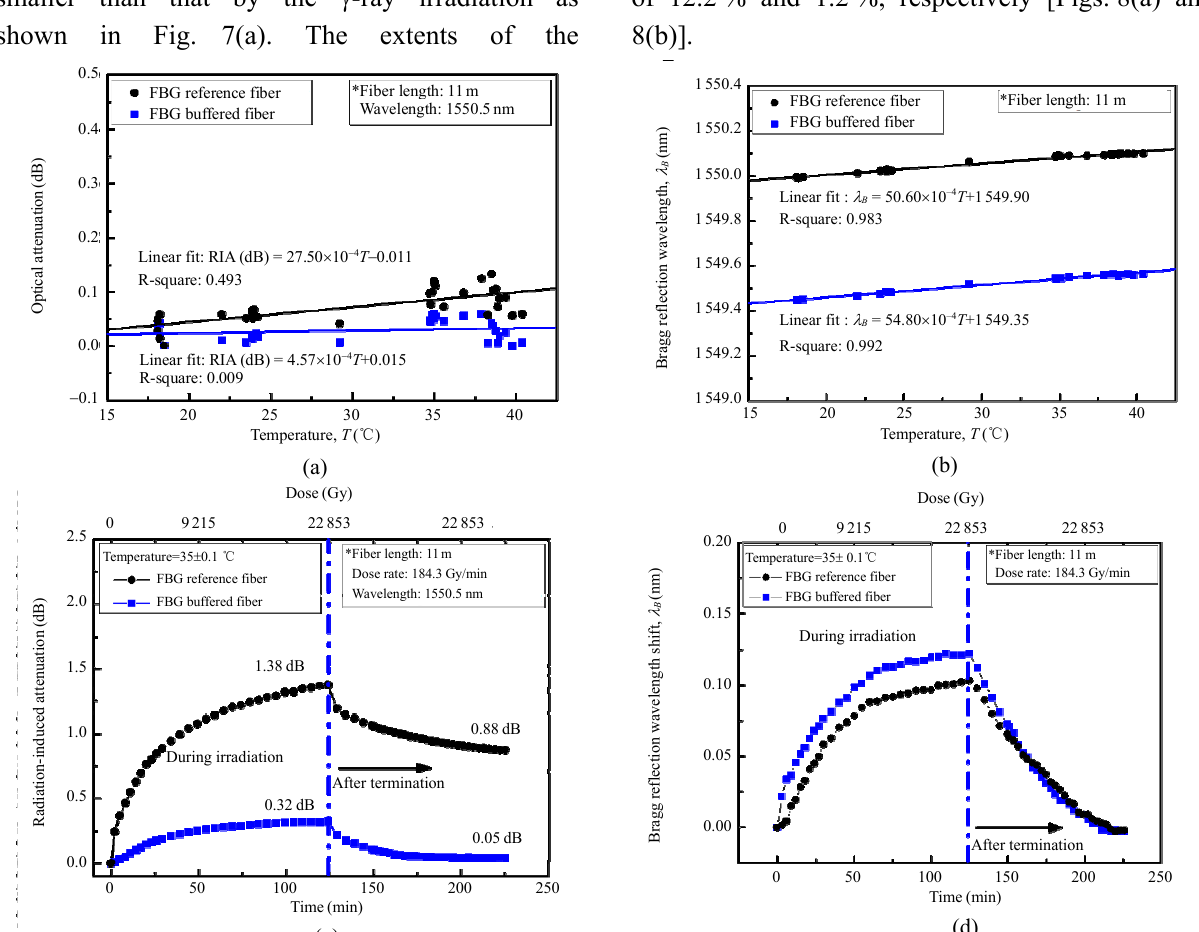
Fig. 8 Variations of (a) the optical attenuation, (b) the Bragg reflection wavelength shift of the FBG fibers from 18 ℃ to 40 ℃ before the γ -ray irradiation, (c) the radiation-induced attenuation, and (d) the Bragg reflection wavelength of the FBG fibers during and after the γ -ray irradiation with the total dose of 22.85 kGy at 35 ℃